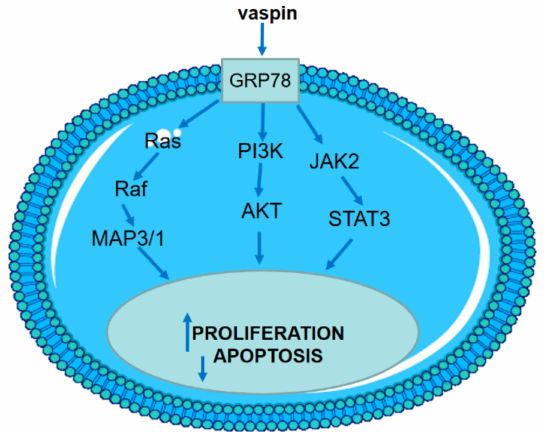
Figure 7. Model of signal-transducing pathways regulating porcine Gc proliferation and apoptosis: Vaspin stimulate proliferation and inhibit apoptosis by binding the GRP78 receptor and by leading to MAP3 / 1, AKT, and STAT3 kinases